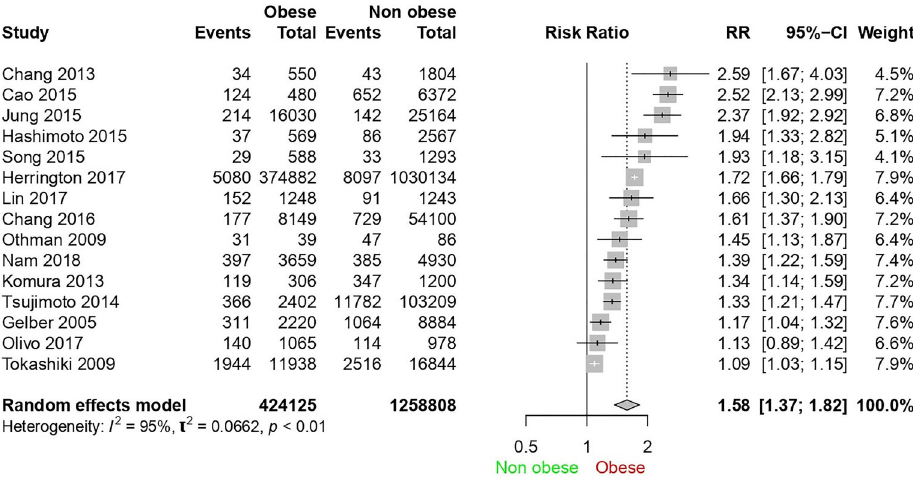
Figure 6. Forest plot for complementary sensitivity analysis excluding articles with kidney transplantation, dialysis, and estimated glomerular fi ltration rate below 15 mL (cid:1) min – 1 (cid:1) (1.73 m 2 ) – 1